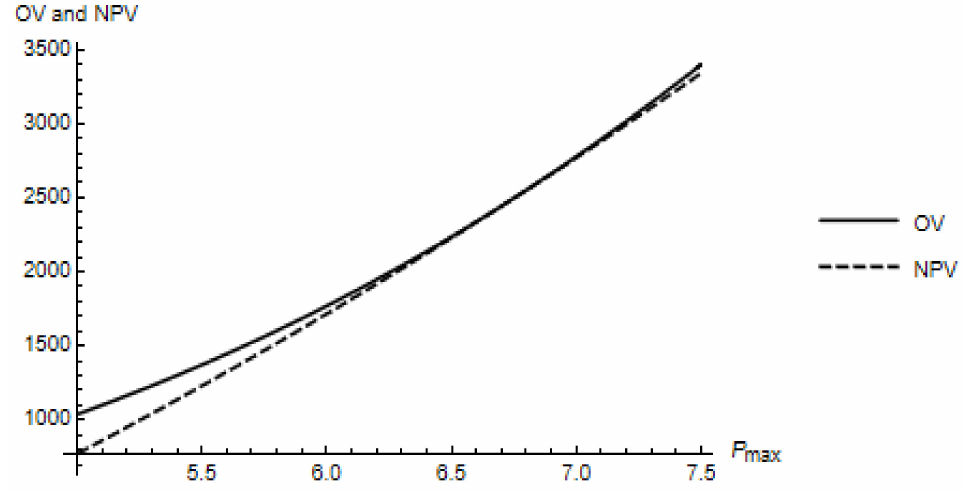
Figure 9. Option value vs. ∆ NPV and optimal investment